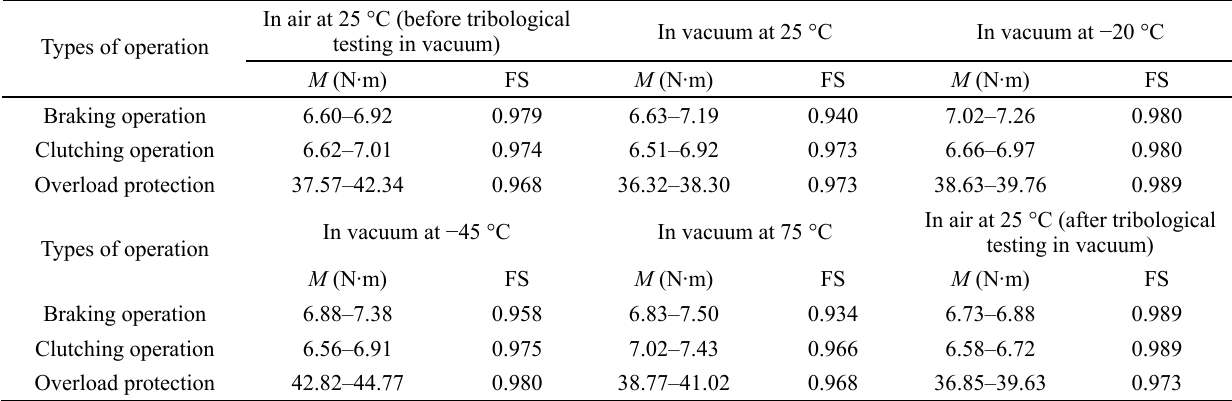
Table 4 M and FS of the brake for docking mechanism under different conditions. In air at 25 °C (before tribological In vacuum at 25 °C In vacuum at − 20 °C testing in vacuum) Types of